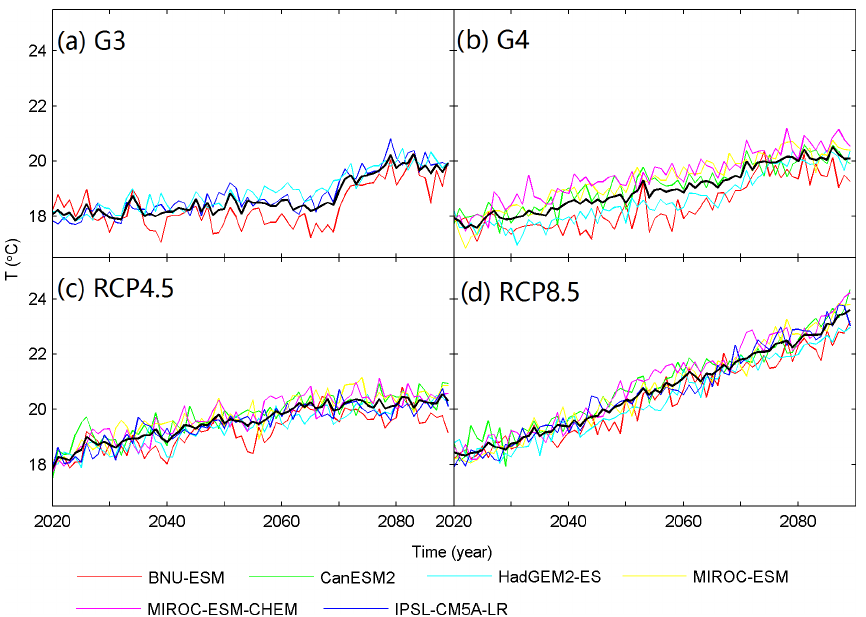
Figure 2. Time series of summer mean bias-corrected temperature averaged over the downscaled grid in the whole HMA region projected by ensemble members under climate scenarios G3 (a) , G4 (b) , RCP4.5 (c) , and RCP8.5 (d) . Black curve in each plot is the mean of the relevant ensemble (Table 3).